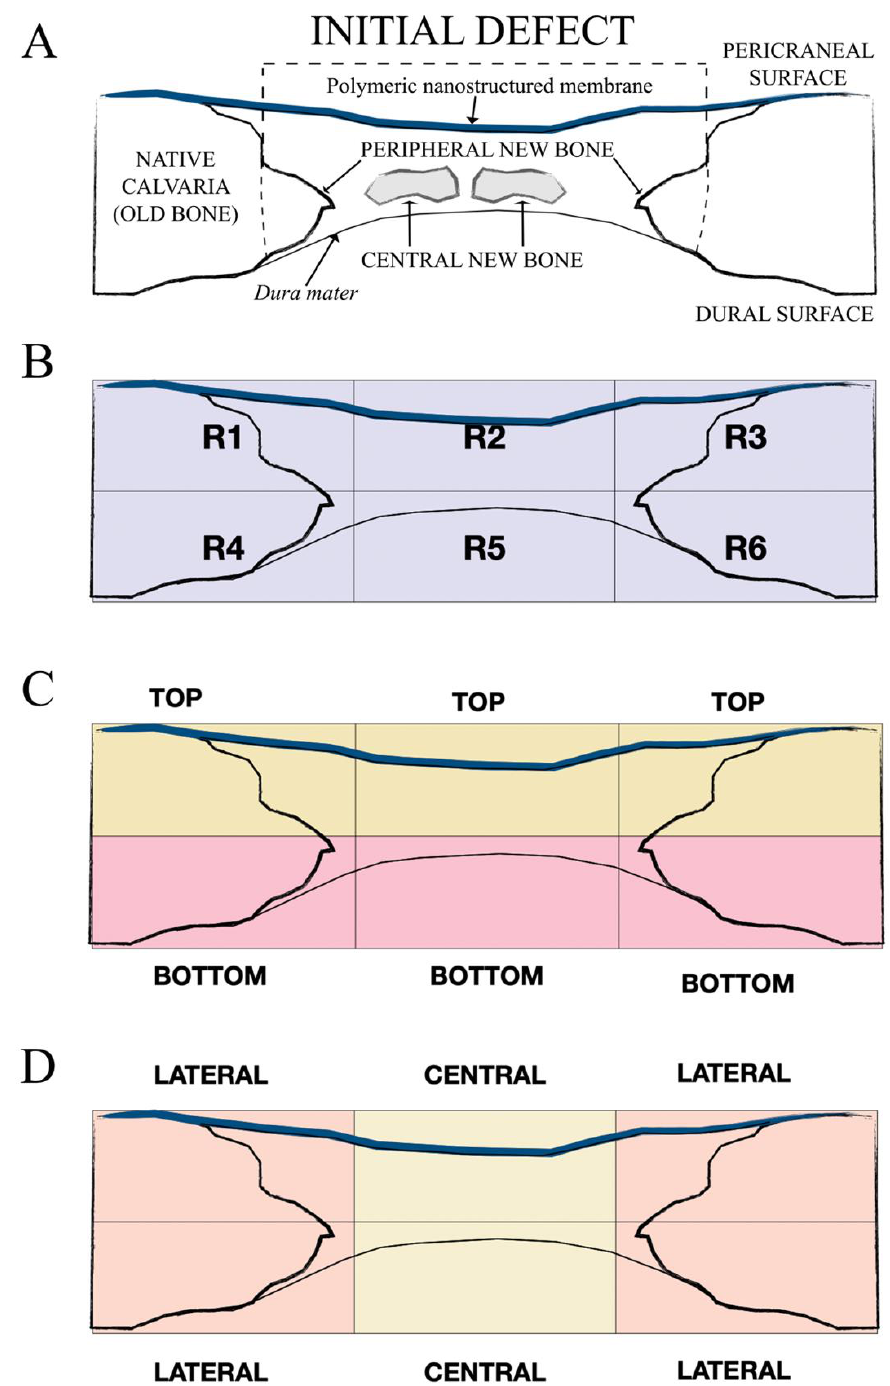
Figure 2. Schematic diagrams showing the defect and the areas of measurement for histomorphom- etry. ( A ) Histometric analysis of the new bone within the calvarial defect distinguishing between peripheral new bone in continuity with the native calvarial (old bone) and central new bone not in continuity with the calvarial edges. A software rectangular grid consisting of six regions ( B ) covered the entire area of the defect. Top (close to the membrane area; R1, R2, and R3 in B) and bottom (close to the dura mater ; R4, R5, and R6 in B) areas are represented in ( C ). Lateral or peripheral (adjacent zone to the old bone or native calvarial; R1, R3, R4, and R6 in B) and central (sum of the remaining areas; R2 and R5 in B) zones are represented in ( D ).